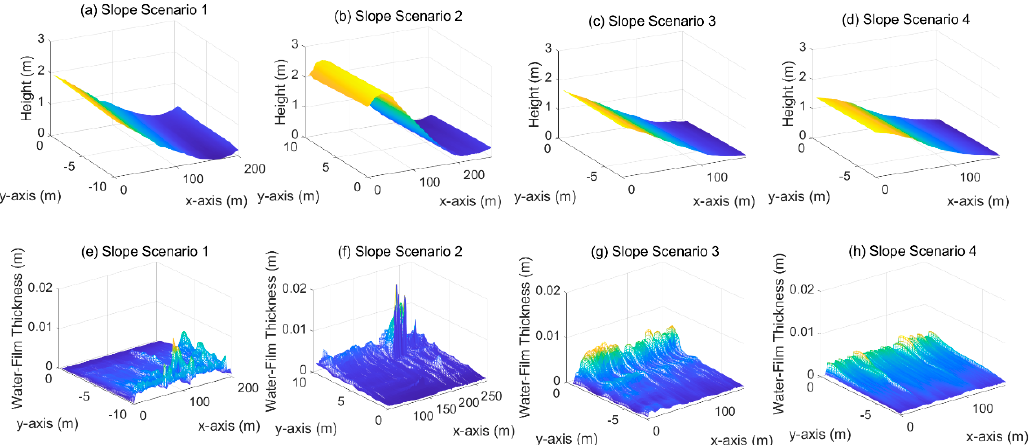
Figure 13. Water-film estimation results on road surfaces with a slope. ( a – d ): 3D road surface of slope scenario 1~4; ( e – h ): water-film thickness distribution of slope scenario